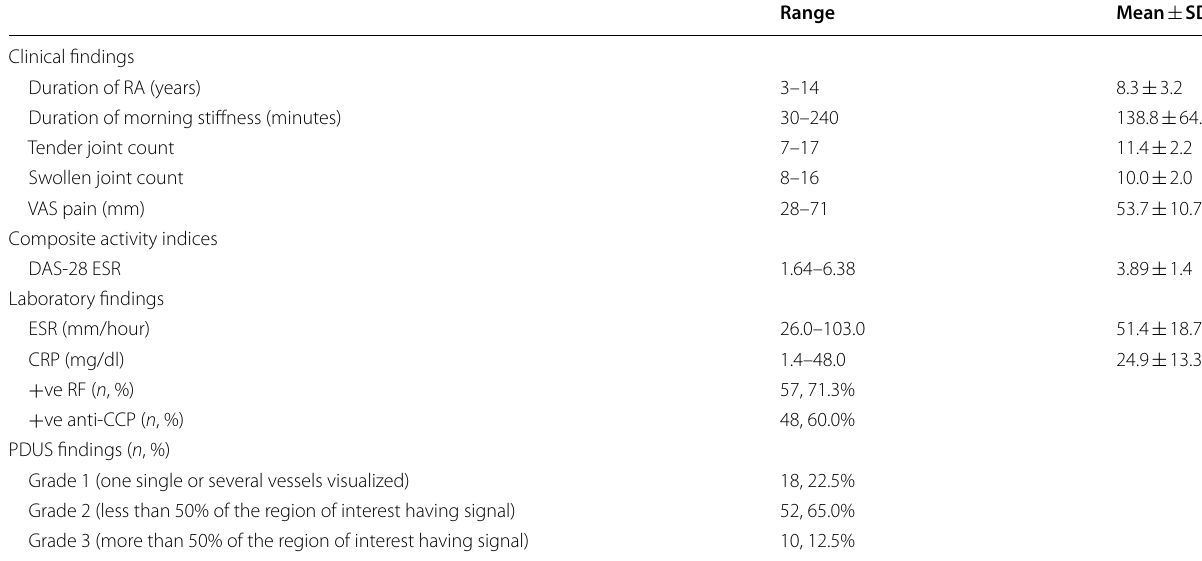
Level of significance at P